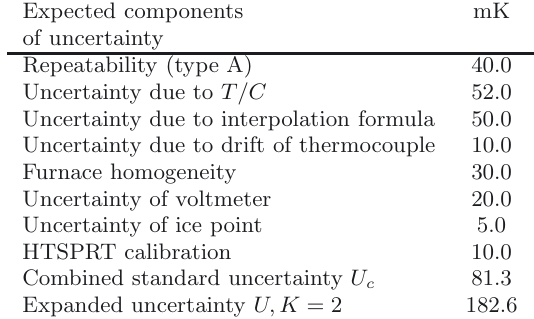
Table 4. The combined Uncertainty U c expressed in the form of 95% confidence level for the calibration of Pt/Pd thermo- couple by comparison in the temperature range from 420 ◦ C to 960 ◦ C with HTSPRT is